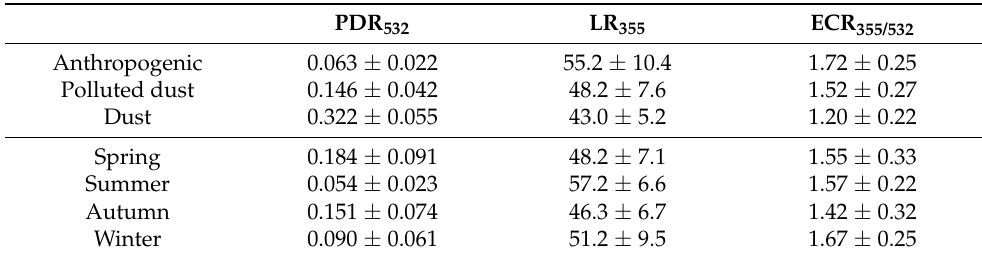
Table 2. Aerosol optical parameters for key aerosol types and different